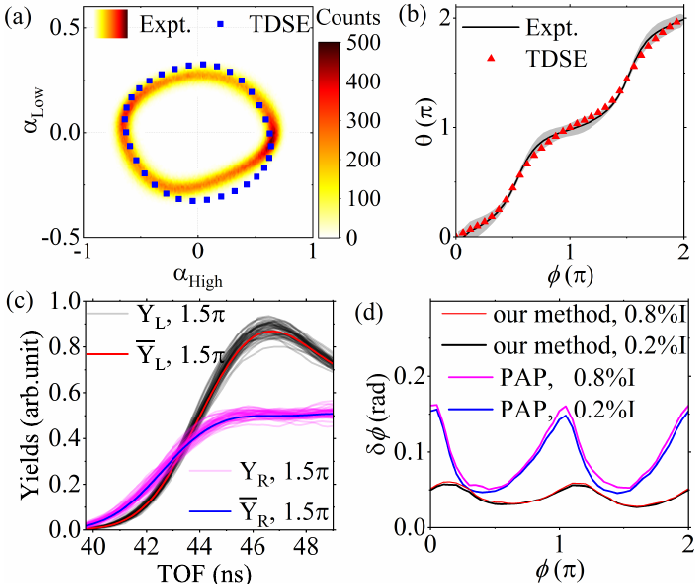
Figure 3. ( a ) The PAP obtained with the typical CEPM procedure with the data given in Figure 2 and TDSE calculations. ( b ) The polar angle ( θ ) as a function of CEP extracted from the PAP in ( a ). The gray shaded area indicates the uncertainties of the experimental data. ( c ) The photoelectron TOF spectra measured by the left ( Y L ) and right ( Y R ) detectors over a small CEP range of φ = 1.5 π ± 5 mrad determined by our procedure for 50 pulses, which are randomly chosen from 1033 pulses for better visualization of the jitter, and the averaged curve of ¯ Y L and ¯ Y R . ( d ) A comparison of the CEP dependence of measurement precision ( δφ ) of our procedure and the standard method employing PAP. See text for more